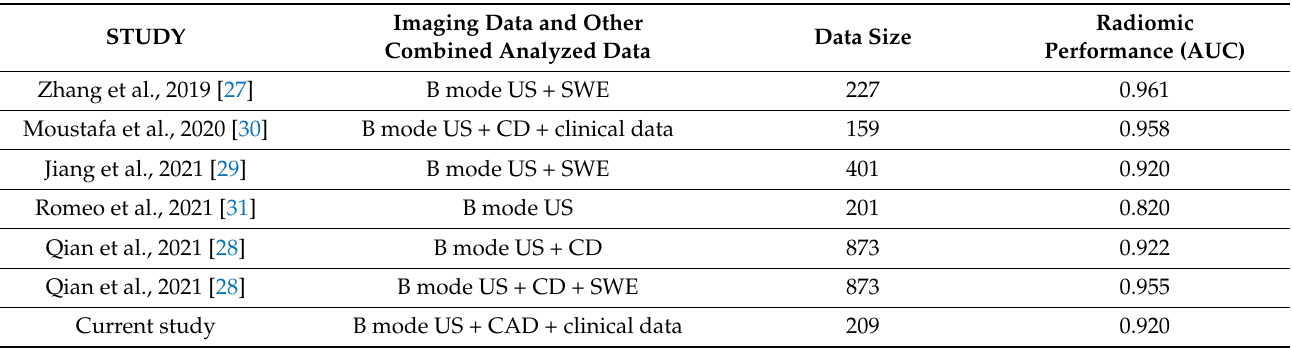
Table 5. Performance comparison (AUC) between our study and other similar studies on the application of radiomics in US